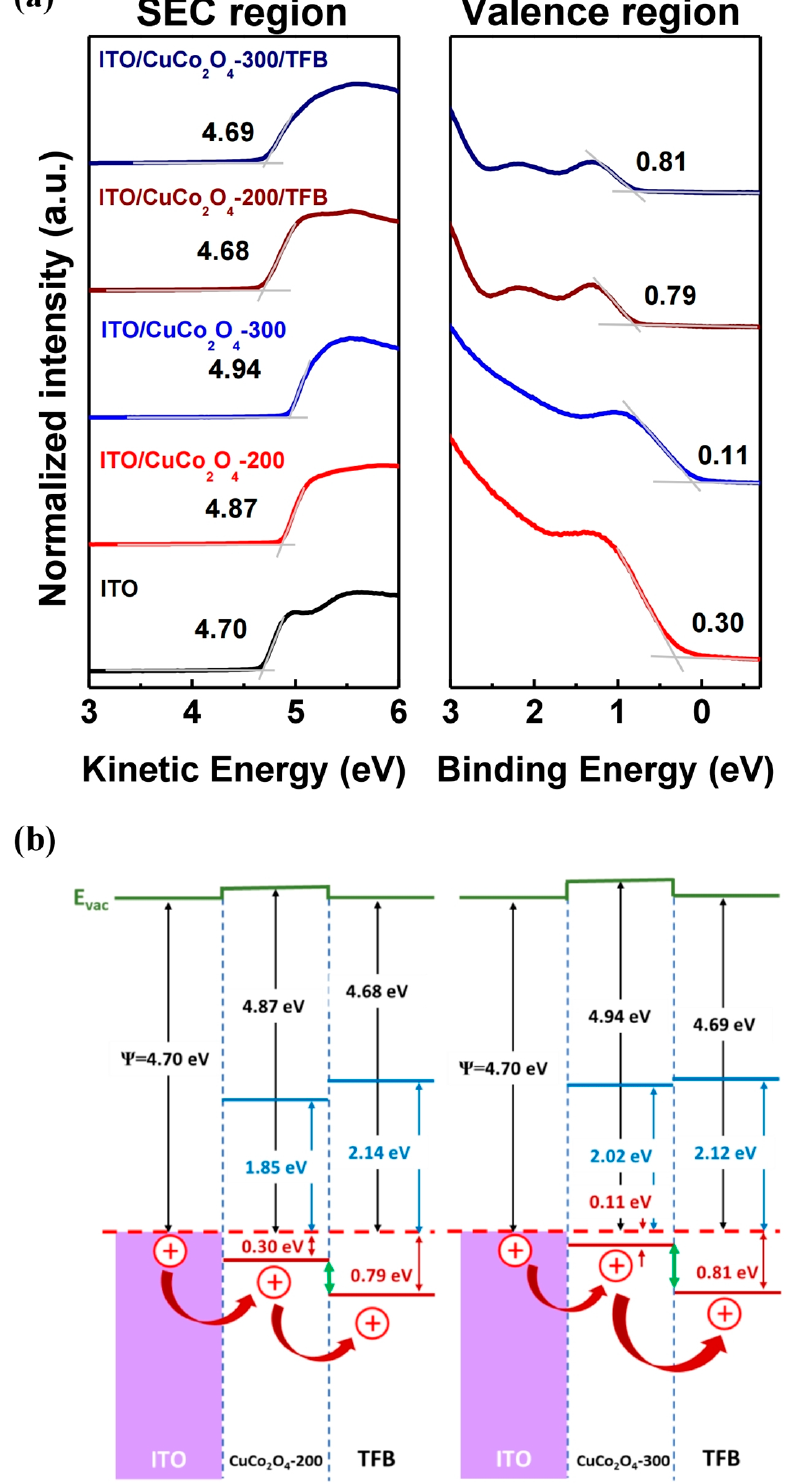
Figure 4. ( a ) UPS spectra of ITO, ITO/HILs and ITO/HILs/HTL measured SEC (left) and valence region (right). ( b ) Detailed interfacial energy-level alignment of CuCo 2 O 4 with ITO and TFB. To confirm the degree of hole injection in actual devices according to the CuCo 2 O 4 HILs annealing temperature, the J-V characteristics were measured by manufacturing an HOD of the ITO/CuCo 2 O 4 /TFB/Al structure, as displayed in Figure 5a. An EOD with an ITO/ZnO/Al structure was also fabricated to compare the injection and transport proper- ties of the electrons and hole carriers. Figure 5b shows that more current flows in the EOD than in the HOD, which can be expected based on the characteristics of holes and elec- trons. Remarkably, the current density of the HODs using the ternary metal oxide CuCo 2 O 4 HIL was nearly 100 times higher than that of the binary metal oxide CuO. In addition, as expected from the UPS measurement results, it can be confirmed that hole injection increases in the CuCo 2 O 4 -200 HOD, which exhibits suitable energy alignment with the TFB. Therefore, we expect that the CuCo 2 O 4 HIL can improve the performance